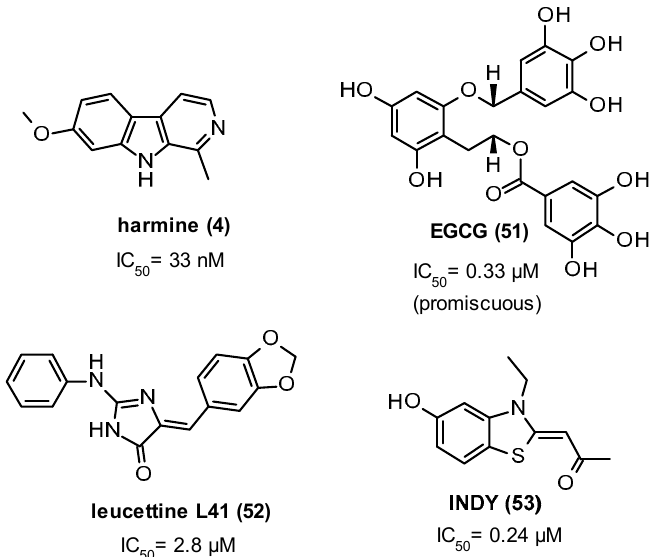
Figure 11. Chemical structures of major representatives of DYRK1A inhibitors.